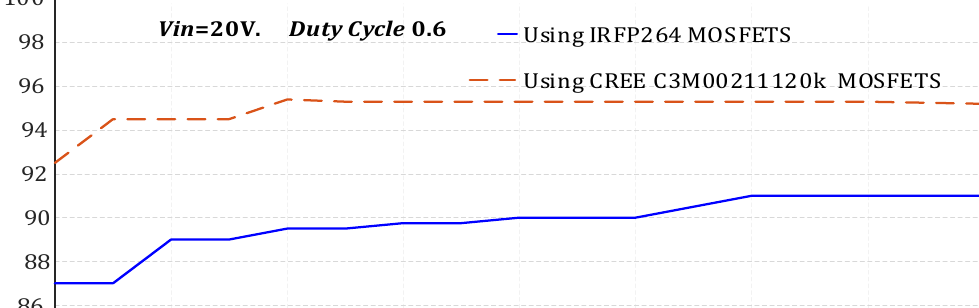
Figure 18. The measured efficiency.